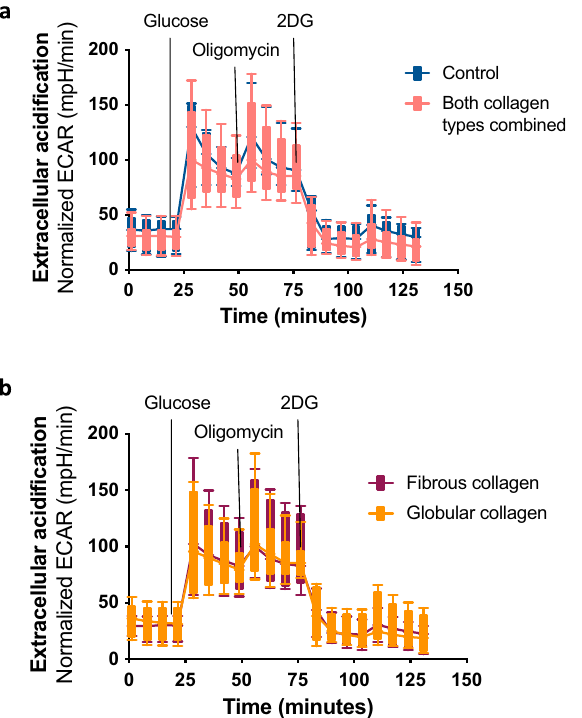
Figure 4. Extracellular acidification rate of alveolar macrophages cultured in collagen-coated or uncoated wells. After 72 h, extracellular acidification rate (ECAR) was measured by glycolysis stress test using an XFe96 extracellular flux analyzer and rates were normalized to protein concentrations. Macrophages were treated sequentially with glucose, oligomycin (ATP synthase inhibitor), and 2-DG (2-deoxyglucose). ( a ) Kinetic ECAR response of macrophages seeded in wells that were either coated with fibrous or globular collagen (data combined) or left uncoated (control). Each data point represents mean ± SD of 6 different experiments. Each single experiment had 6 technical replicates that were averaged. ( b ) Kinetic ECAR response of macrophages seeded in wells that were either coated with fibrous or globular collagen. Each data point represents mean ± SD of 6 different experiments. Each single experiment had 6 technical replicates that were averaged. Data represented as a box and whiskers plot, where the box and whiskers extend from the 10th to 90th